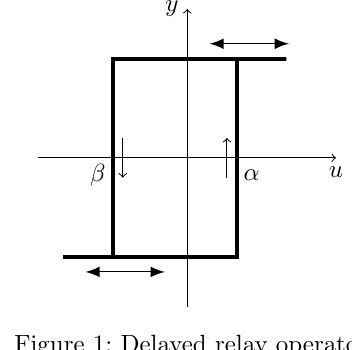
Figure 1: Delayed relay operator.